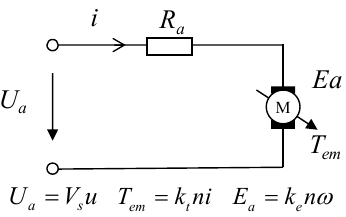
Figure 4. The electrical circuit of the DC motor of each wheel.